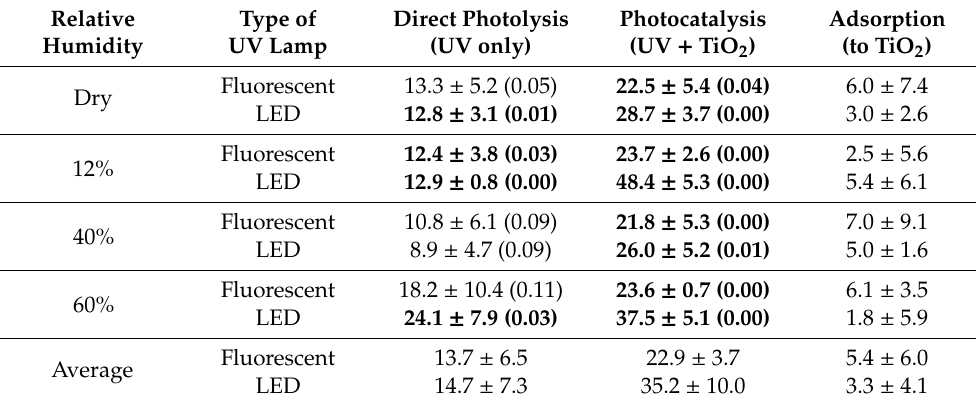
Table A12. O 3 mitigation under di ff erent light types and relative humidity at 200 s. Values report % reduction ± st. dev. (p-value) and are an average between treatments of NH 3 and H 2 S. Bold font signifies statistical significance.